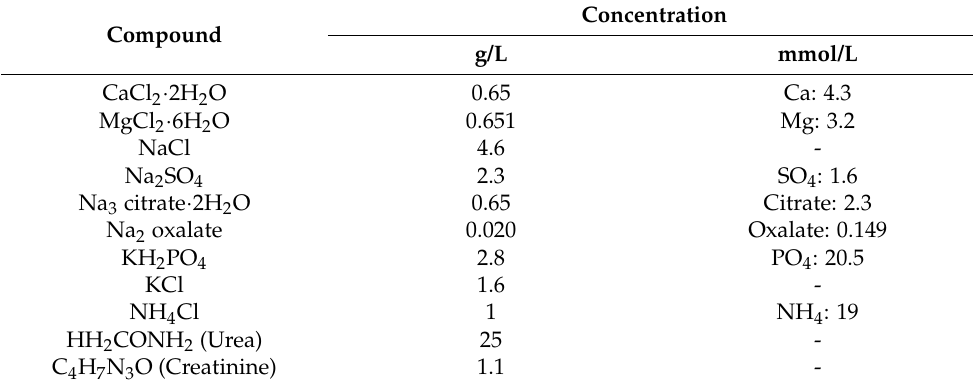
Table 3. Compositions of synthetic